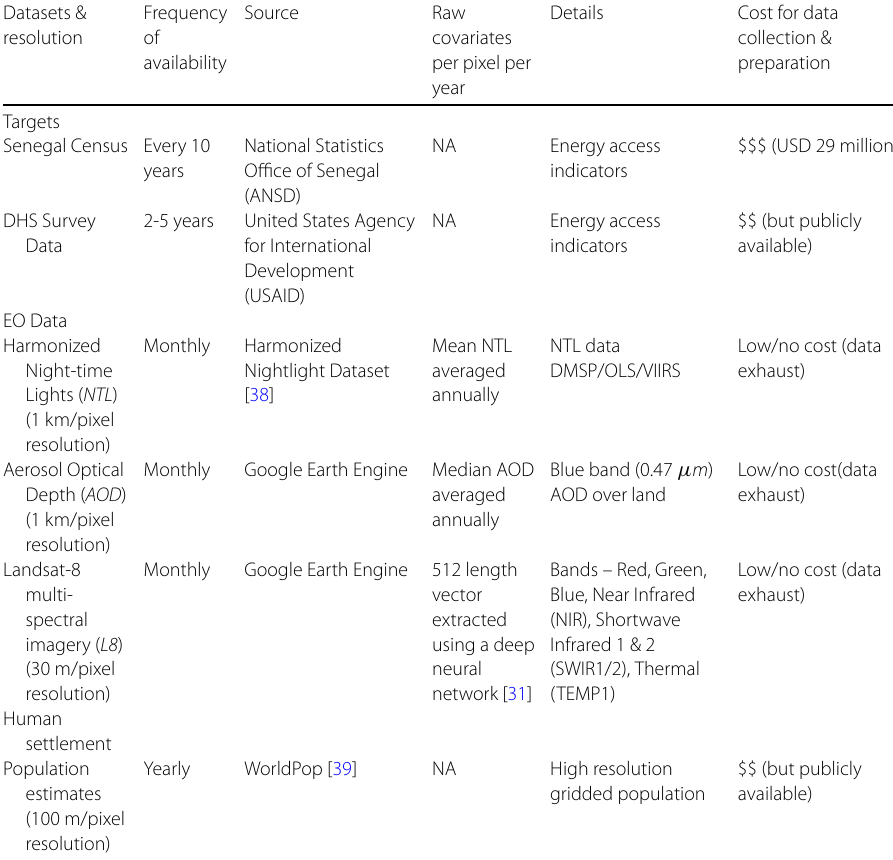
Table 1 Description of disparate data sets used in the study. The first two rows corresponding to census and survey data are used to create targets for our model. The next three rows, NTL, AOD and L8 are EO datasets used to extract covariates. The last row corresponding to population data is used in getting settlement information and is used in weighting the covariates of EO features. DMSP/OLS/VIIRS refers to the Defense Meteorological Satellite Program/Operational Linescan